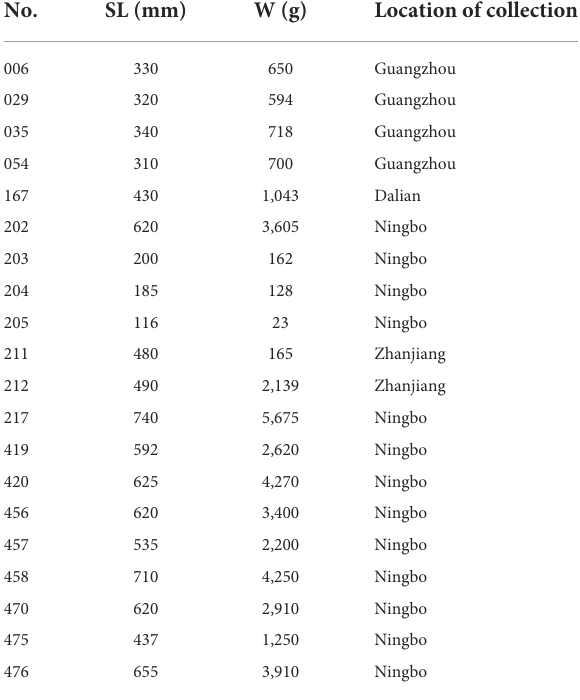
TABLE 1 Standard length, weight, and location of collection of Chinese sea bass ( Lateolabrax maculatus ) used in this